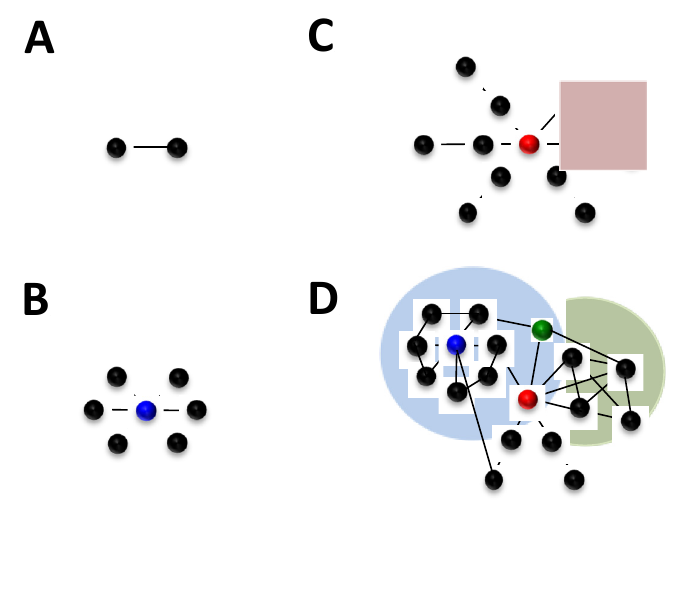
Figure 1. Basic concepts in network analysis. ( A ) Two nodes are connected by an edge. ( B ) One node is connected to several nodes, the blue color denotes the highest connectivity ( k ) value within the network. ( C ) The red node displays high centrality ( b ) . The red square designates a 4-node clique. ( D ) The network is more complex, the red node indicates the node with the highest centrality, but is not the node with the highest connectivity (blue node). The light green and blue circles show two communities in this network, and their shared nodes, the bridging node is shown as